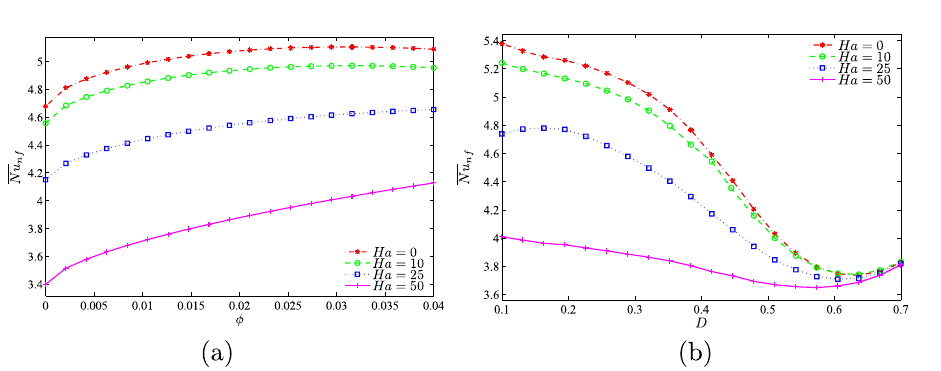
Figure 15. Variation of average Nusselt number with ( a ) φ and ( b ) D for different Ha at Ra = 10 5 , k w = 0.76 and D =